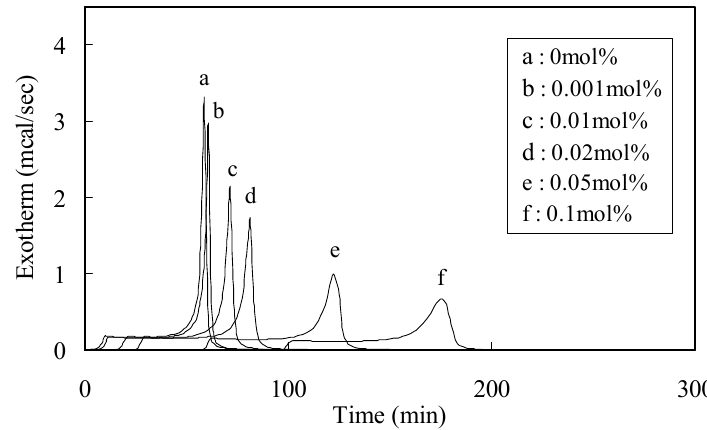
Figure 1. Exothermic curves for the polymerization of MMA with BPO in the presence of capsaicin.